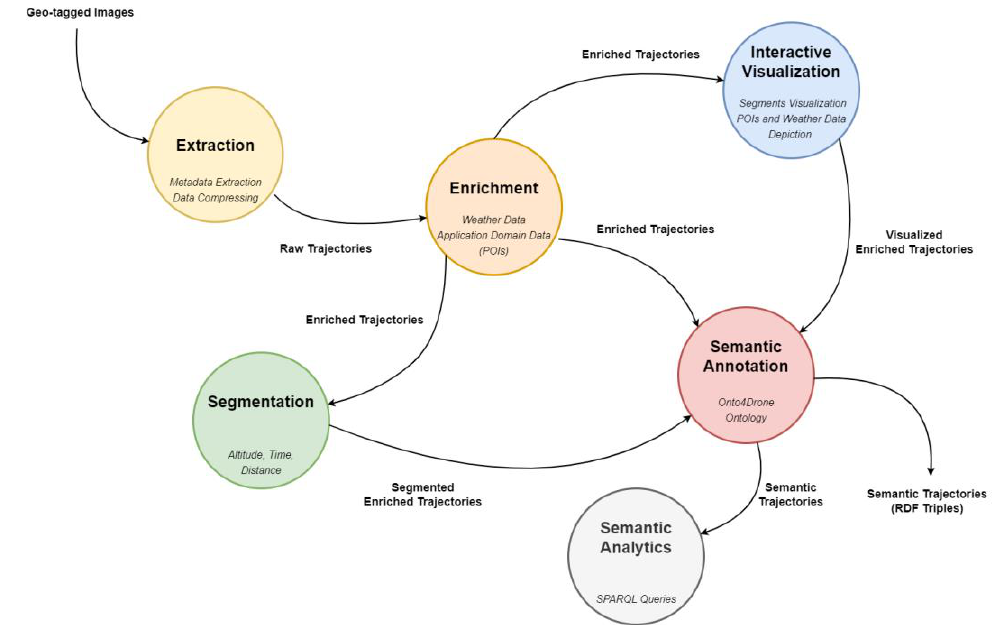
Figure 2. Workflow of the trajectory reconstruction, semantic annotation, and analytics.